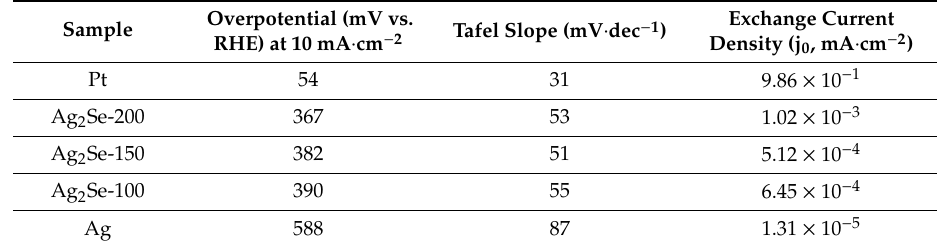
Table 1. HER parameters for Ag 2 Se, Ag, and